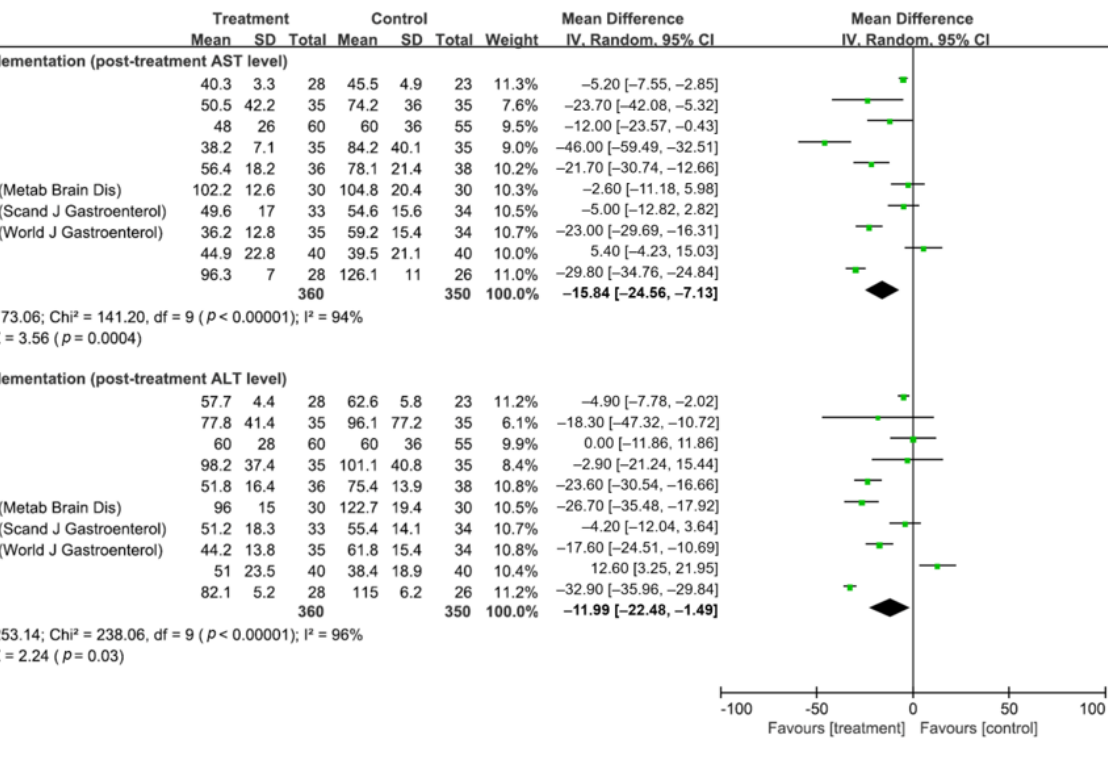
Figure 3. Forest plot of post-treatment serum AST and ALT levels after L -carnitine (or acetyl- L - carnitine) supplementation versus control treatment. Parentheses following the first author’s name indicate the journal in which the study was published. * Multiple doses were investigated in this study. Data from the maximal dosage group (3 g/day) were used in the analysis. ALT, alanine aminotransferase; AST, aspartate aminotransferase; CI, confidence interval; df, degrees of freedom; IV, inverse variance; SD, standard